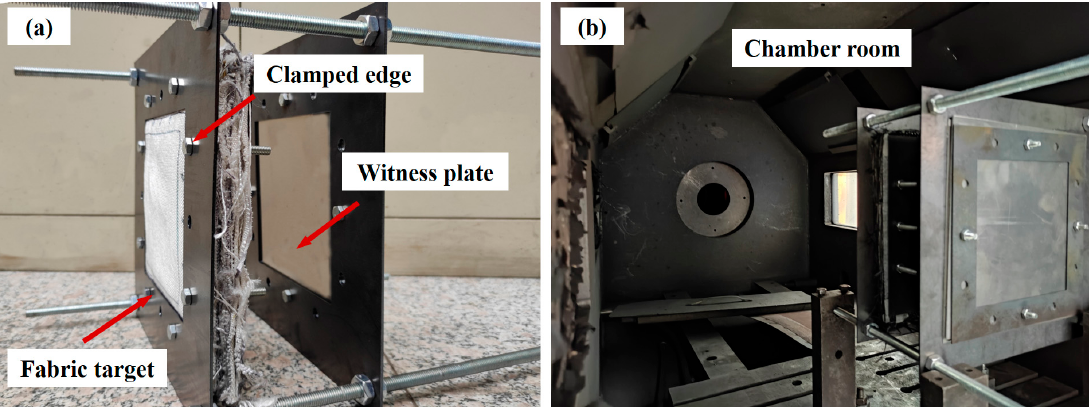
Figure 3. HVI experiments equipment. ( a ) Installation of target. ( b ) Experimental chamber room. The fabric was stacked along the thickness direction and glued on the edge of the fabric, effectively preventing the yarn from pulling off and clamping the edge of the fabric.